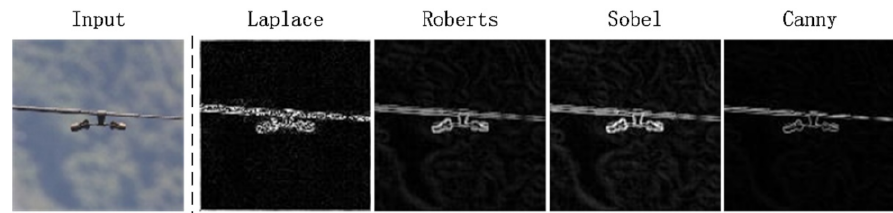
Figure 1. Test examples of edge detection algorithm.